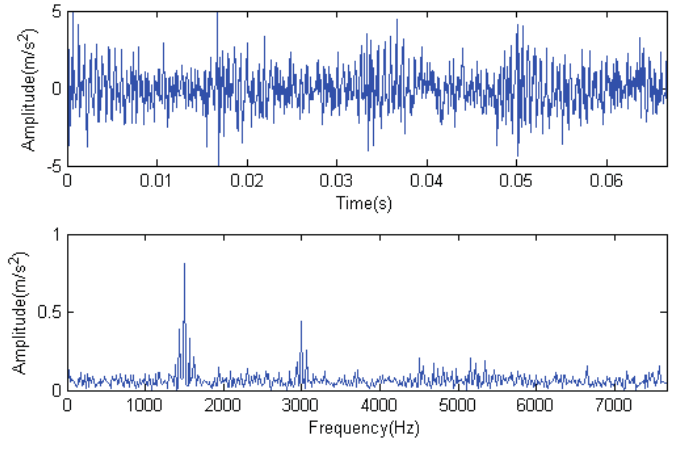
Figure 2. Signal waveform and frequency spectrum with